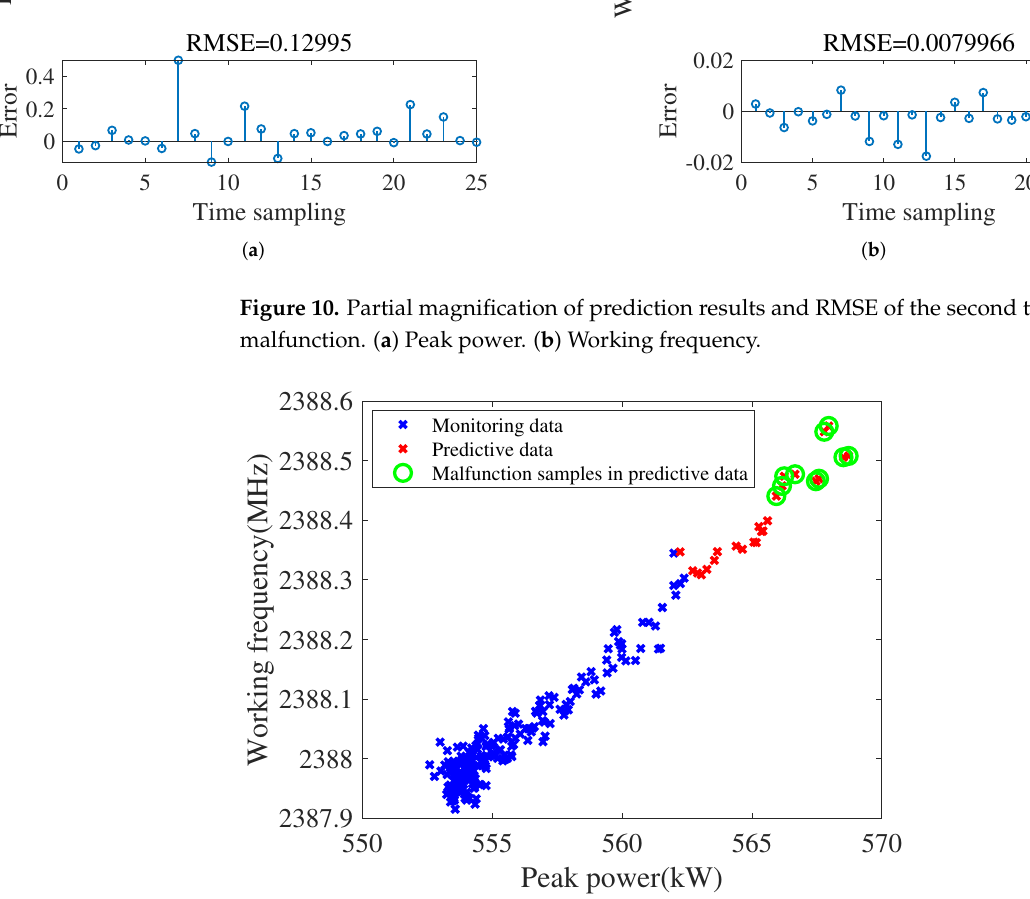
Figure 11. Visualization results of the second type of degradation malfunction prognosis experiment. Table 6. Comparison between the proposed method and the existing